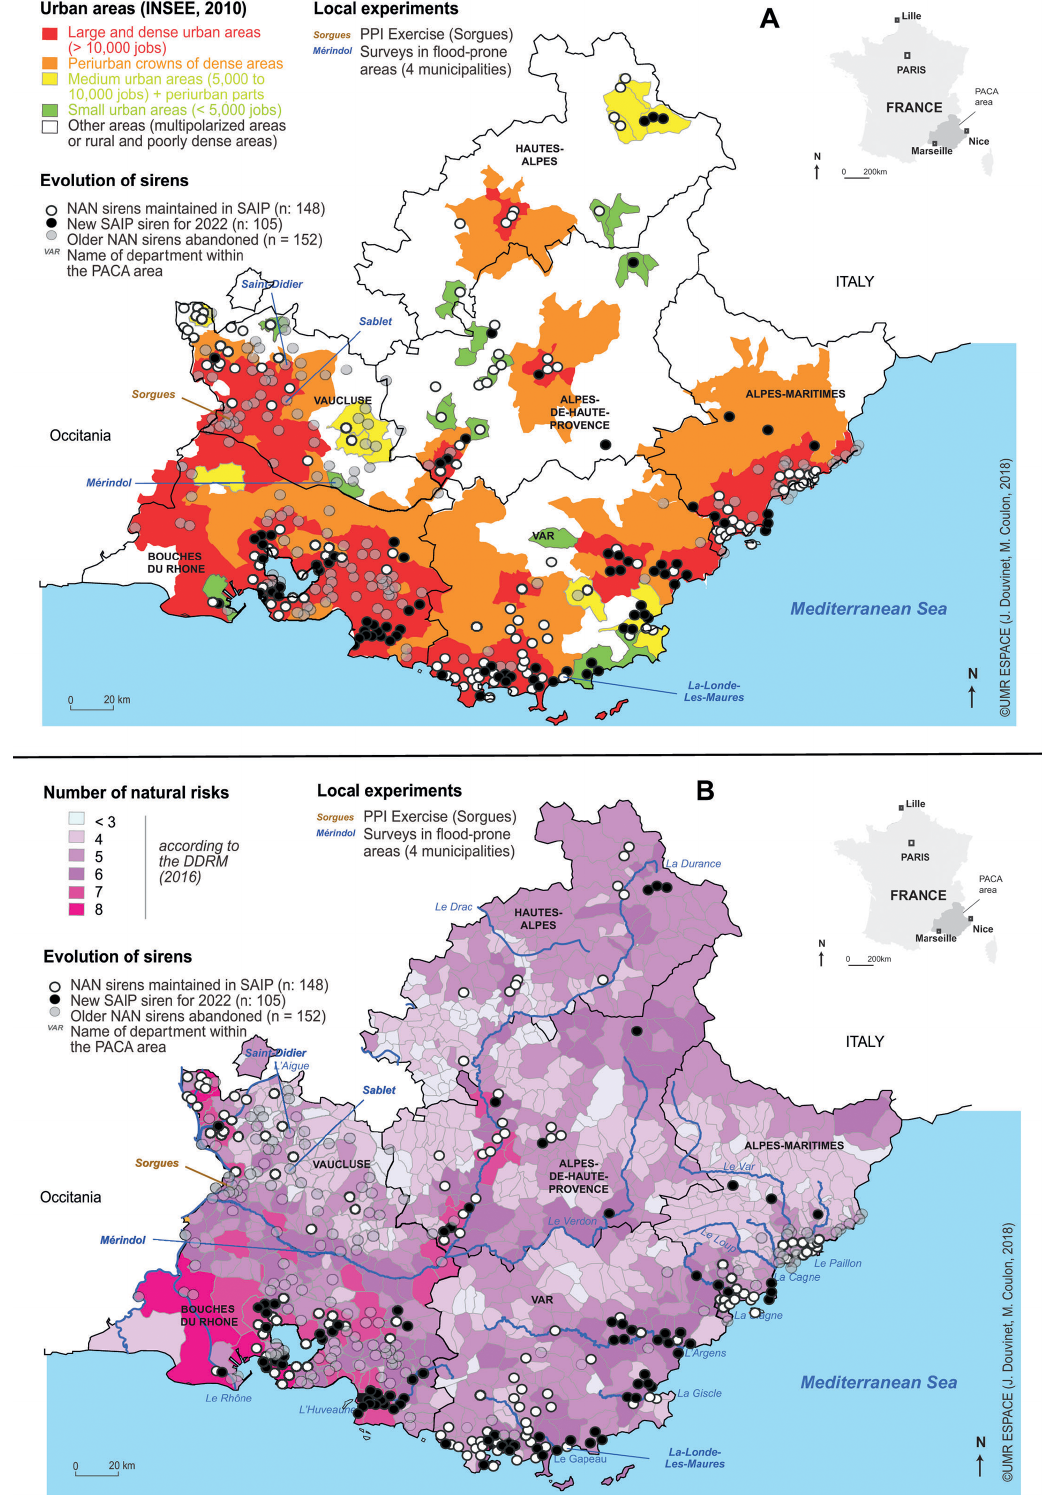
Figure 4. Evolution between the NAN and SAIP networks in the PACA region (Provence–Alpes–Côte d’Azur), related to (a) the urban typology and (b) the number of natural risks indicated by the French Ministry of